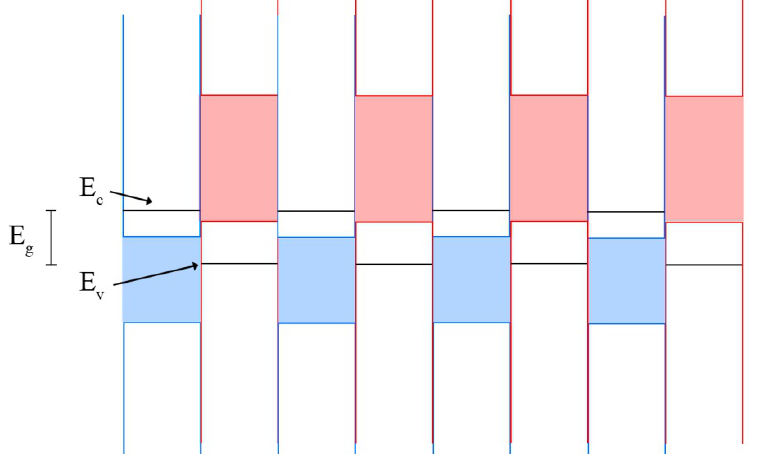
Figure 5. A band diagram of a InAs(blue)/GaSb(red) SLS. Carrier electrons are excited from the valence band of the GaSb layers to the conduction band of the InAs